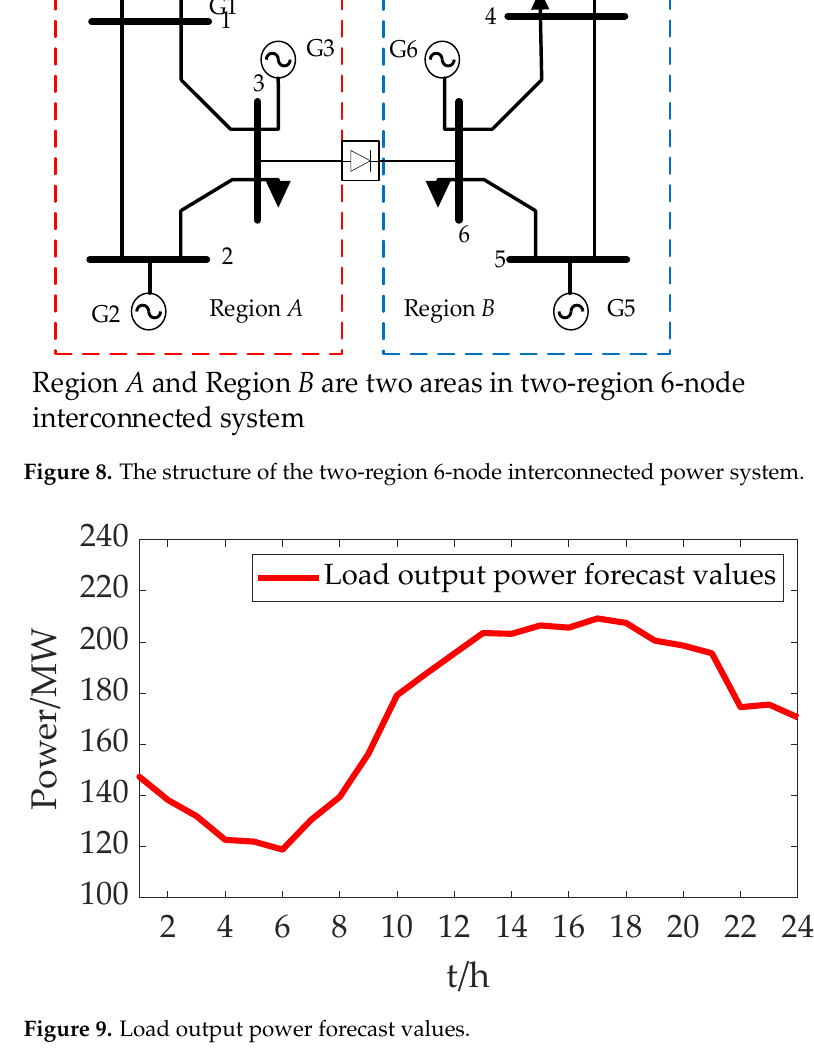
Figure 10. Wind power forecast values and upper and lower limits of wind output power values. In order to analyze the advantages of flexible adjustment of the DC tie-line power, two DC transmission modes were set and compared. Mode 1: The DC tie-line operates in the traditional mode, that is, a constant power mode, with less transmission during the load valley period and more transmission during the load peak period. Mode 2: The flexible operation characteristics of the DC tie-lines are considered, and the DC tie-line power is uniformly optimized. The DC tie-line transmission plans for the two transmission modes are shown in Fig- ure 11. During the low-load period, the DC tie-line power in Mode 2 is higher than in Mode 1. This shows that Mode 2 is beneficial for transferring the surplus wind power from region A to region B during a trough period. By optimizing the transmission power of the DC tie-line, the cross-regional consumption of wind power resource can be realized, the wind power accommodation capacity of the interconnected power grid is effectively improved and the wind abandonment is reduced.